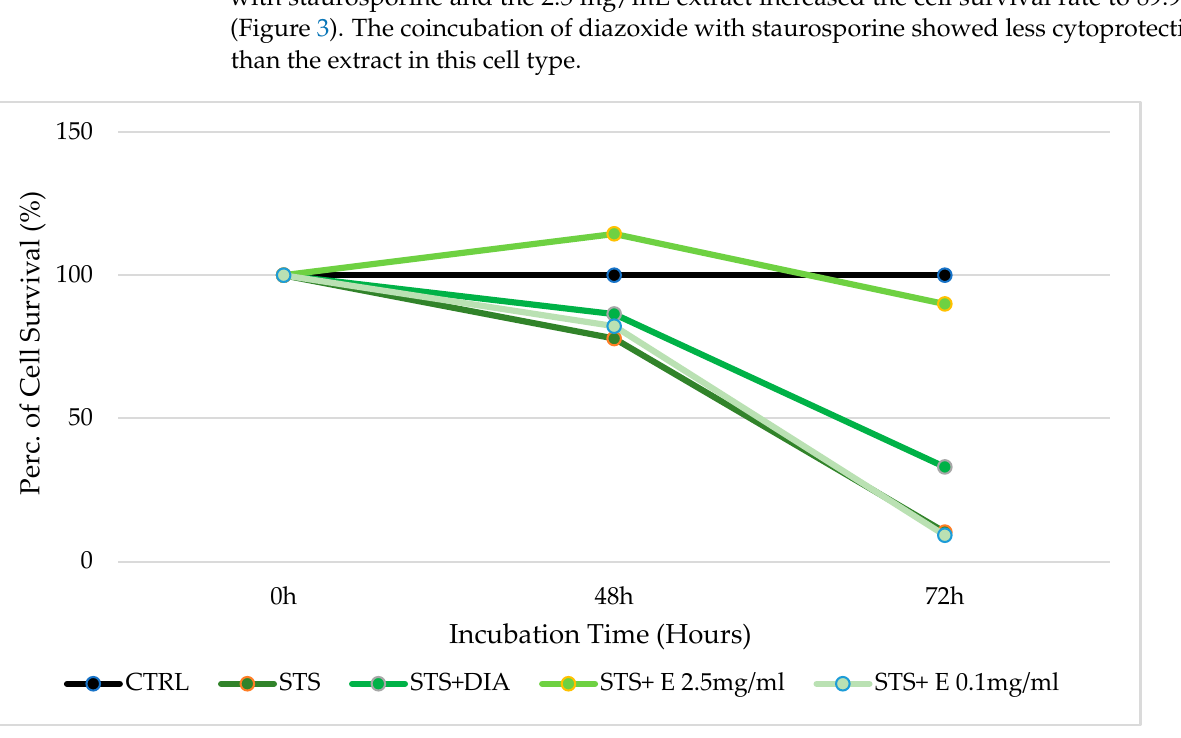
Figure 3. Percentage of cell growth values of osteoblasts co-incubated with staurosporine (STS) alone, staurosporine and diazoxide (DIA), and staurosporine and two different concentrations of the extract (E) measured using the crystal violet assay, compared to controls (CTRL). Data are shown for two different concentrations of the extract (2.5 mg/mL and 0.1 mg/mL) after 0 h, 24 h, 48 h, and 72 h of incubation. One-way ANOVA testing for differences between and within groups of treatments showed significant differences between treatments (F > 1.9 and p < 0.005) at different incubation times for STS and STS + E 2.5, and DIAZO after 72 h (N experiments = 6).